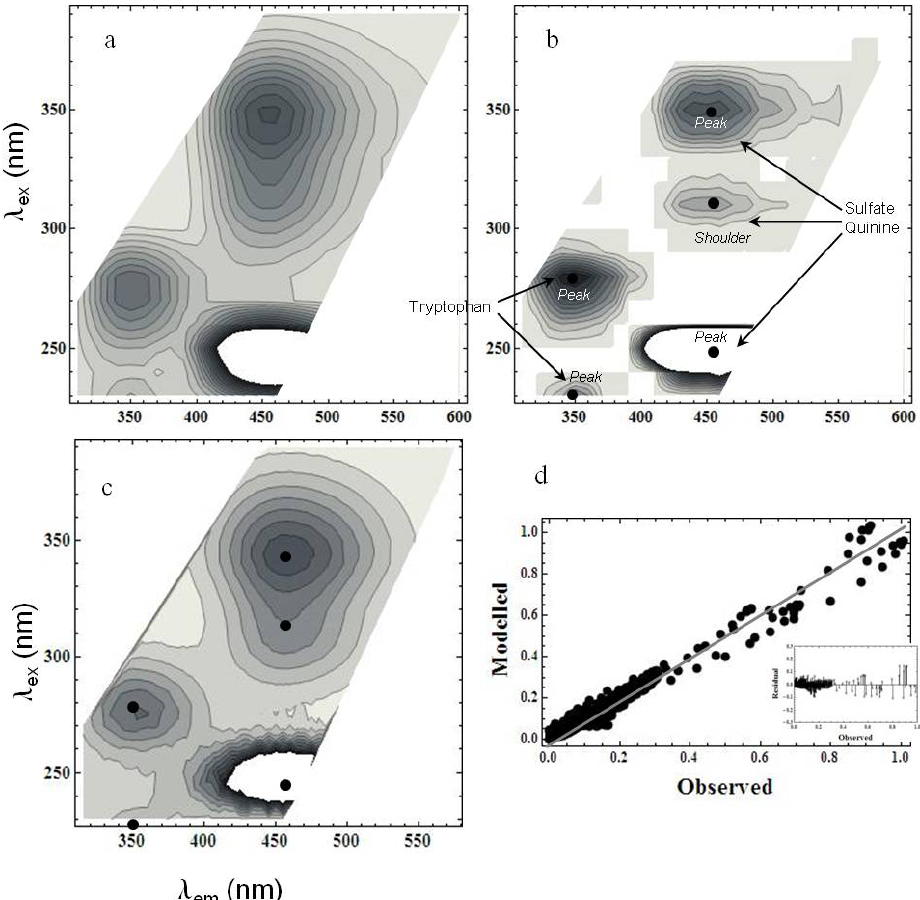
Fig. 1. (a) Contour plot for tryptophan quinine sulfate (TQS) EEM; (b) its laplacian ∇ 2 f ; (c) the modelled EEM; (d) Comparison of the modeled vs. observed TQS EEM (values in Raman units; r 2 = 0 . 985, slope of the fit is 0.97 ± 0.0026). Dots represent each individual fluorescence. The gray line shows the 1 : 1 line. The inset shows the residuals with respect to to the magnitude of the fluorescence